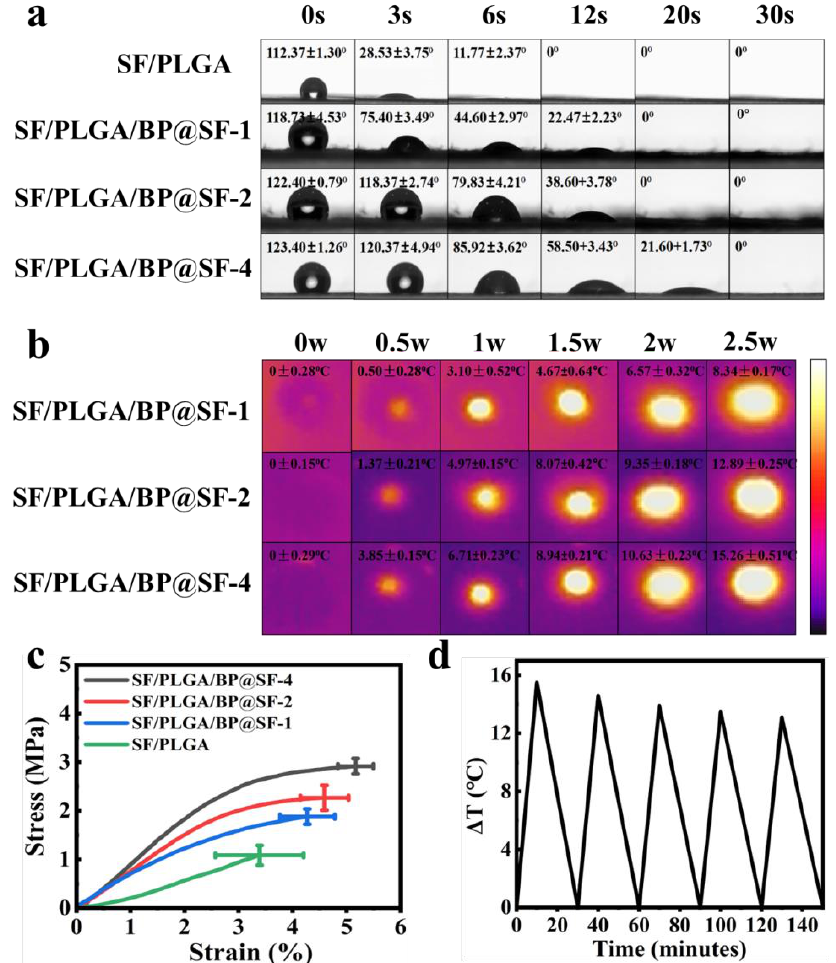
Figure 4. ( a ) The contact angles of the electrospun membranes; ( b ) Photothermal effect; ( c ) Tensile properties; ( d ) the SF/PLGA/BP@SF-4 cycle test of heating under near-infrared irradiation with 2.5 W power.